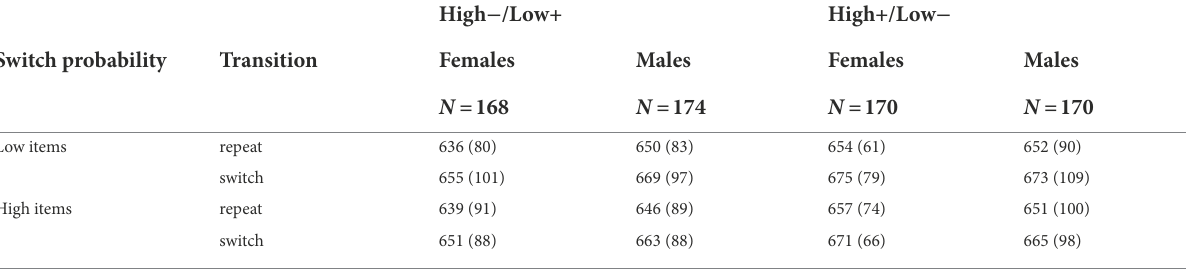
TABLE 7 Mean response times (ms) with standard deviations in Experiment 2 as a function of background valence, switch probability, and transition separately in males and females.